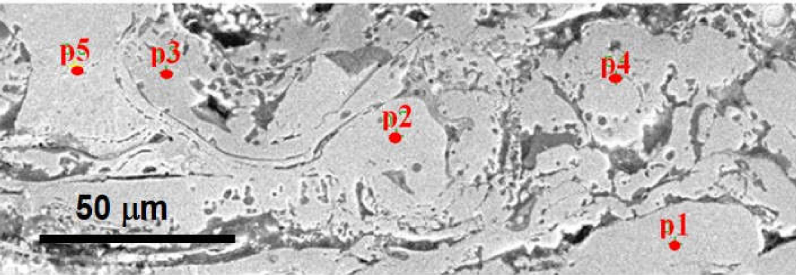
Figure 5. Microstructure of arc-sprayed Fe-Al-type intermetallic coating after annealing at 800 ◦ C for 2 h with hypothetical phase identification based on results of EDX point analysis (in Table 2).